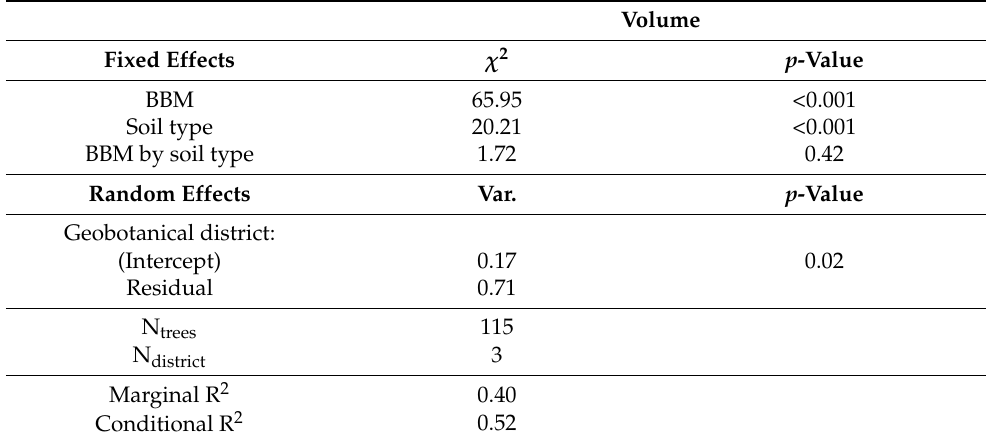
Figure 2. The relationship between relative stem basal bending moment (BBM in kNm) (expressed per stemwood volume in m 3 ) and the volume of soil–root plate (in m 3 ) of pulled and windthrown trees of Eastern Baltic silver birch on freely draining mineral, drained deep peat, and periodically waterlogged mineral soils. Table 2. Strength (Wald’s χ 2 ) and significance ( p -value) of the fixed effects of stem basal bending moment (BBM) and soil type, random variances and significance of the geobotanical district and model performance (R 2 ) for the volume of soil–root plate of Eastern Baltic silver birch on freely draining mineral, drained deep peat, and periodically waterlogged mineral soils.